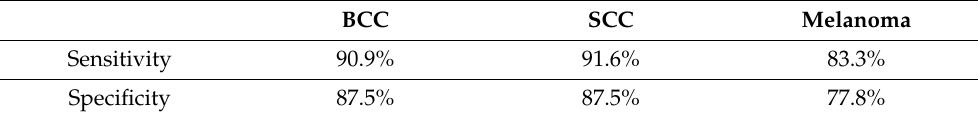
Table 1. The sensitivity and the specificity of the three different cancerous tissues trained using 60 samples, when compared with normal skin. The sensitivity and specificity equations used were defined previously